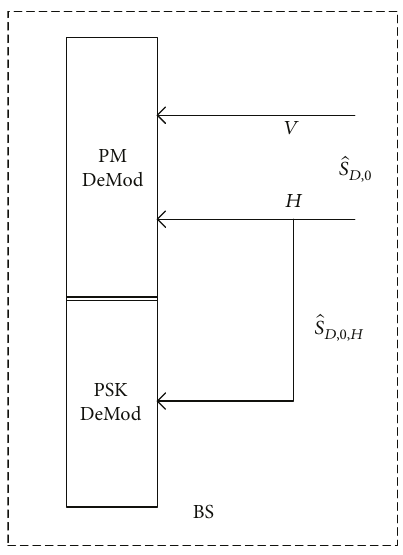
Figure 6: Joint demodulation